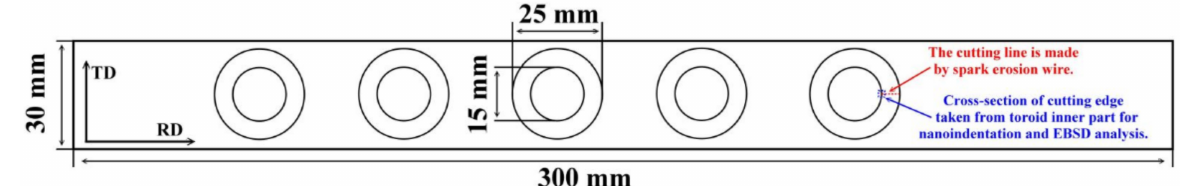
Figure 1. Scheme of ring samples cutting. TD = transverse rolling direction, RD = rolling direction, EBSD = electron back-scattered